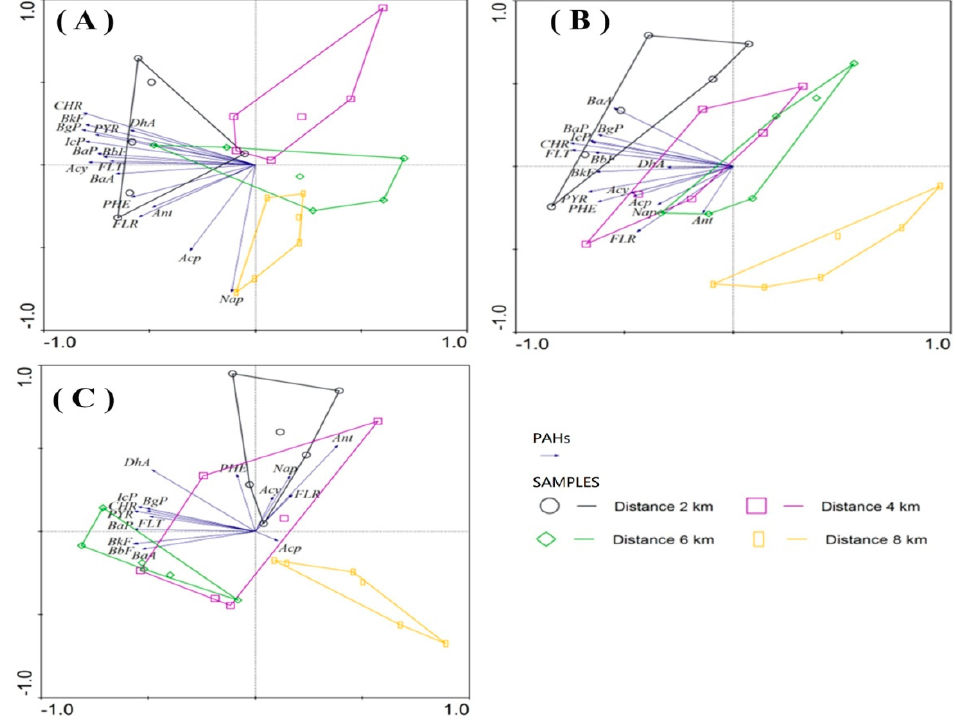
Figure 3. Redundancy analysis (RDA) of the correlation between distance (from urbanization) and the PAHs concentrations in ditch wetlands ( A ), agricultural lands ( B ), and riverine wetlands ( C ). The black group represents a distance of 2 km, the purple group represents a distance of 4 km, the green group represents a distance of 6 km, and the orange group represents a distance of 8 km.